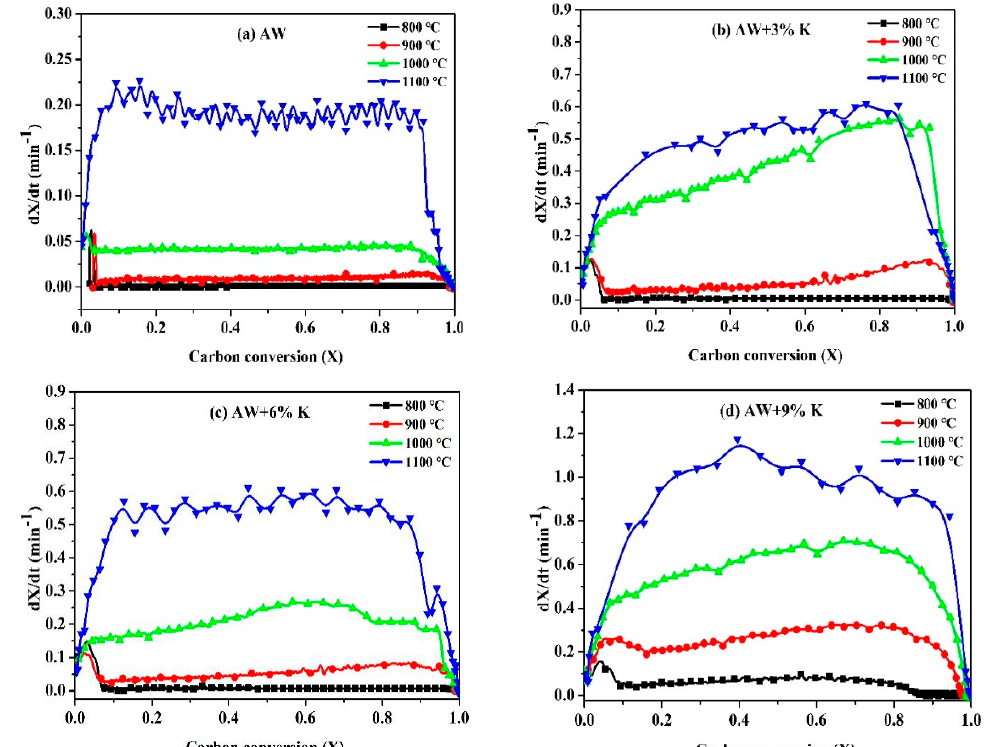
Figure 3. Gasification reactivity of different KCl concentration versus carbon conversion profiles at different temperatures.